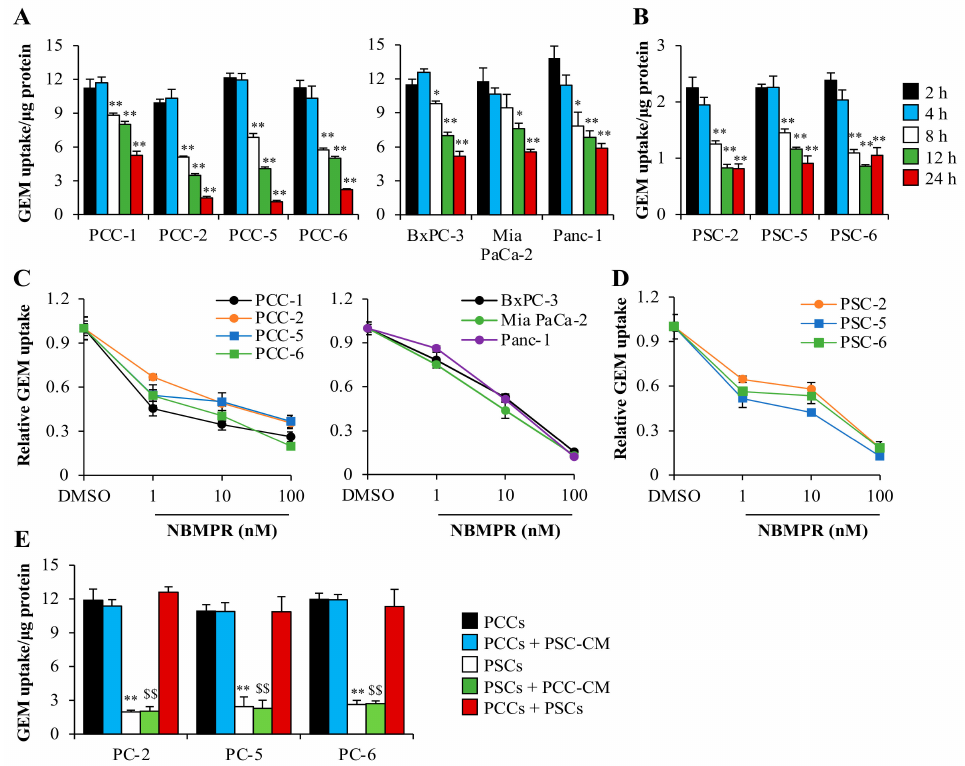
Figure 2. Assessment of intracellular gemcitabine transport. Human PDAC-derived primary